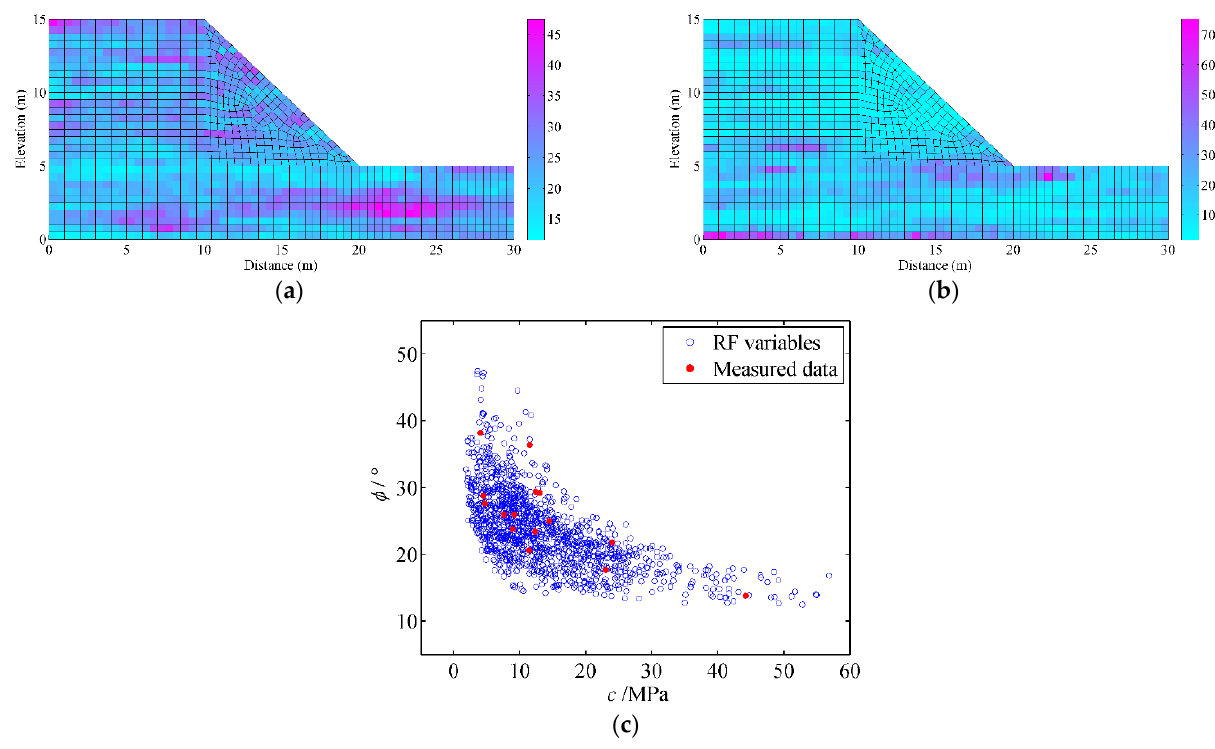
Figure 26. A typical realization of CCRF for soil parameters of the Papillion River Basin slope. ( a ) Random field of c. ( b ) Random field of ϕ. ( c ) Scatter plot of CCRF variables and measured data.